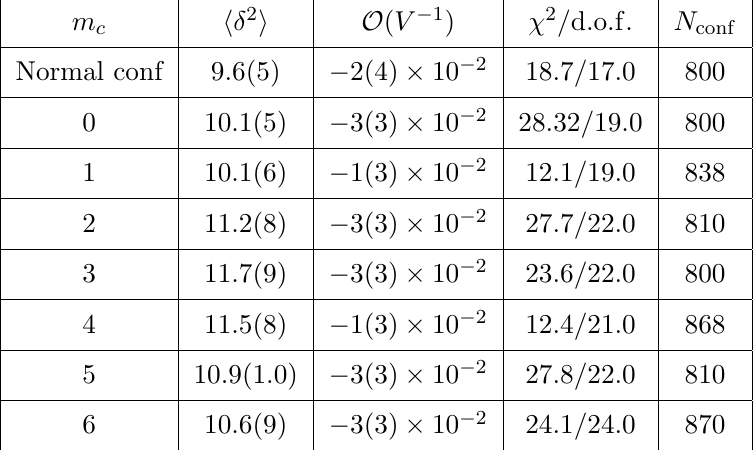
Table 5 . The (cid:12)tting results of h (cid:14) 2 i and correction term O ( V (cid:0) 1 ) for each magnetic